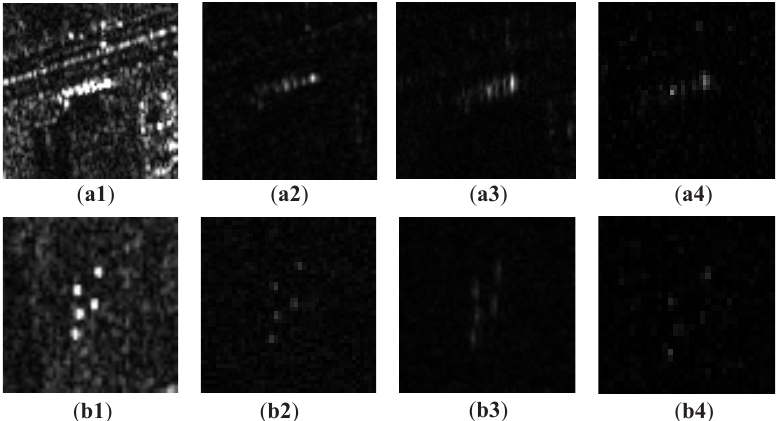
Figure 16. Comparisons of the suppression performance of strong clutter, ( a1 ) a strong building on the road-side, ( a2 – a4 ) the suppression result by the DPCA, the Deramp-STAP and the proposed algorithm, ( b1 ) the corner reflectors that we placed on the road-side, ( b2 – b4 ) the suppression result by the DPCA, the Deramp-STAP and the multilayer